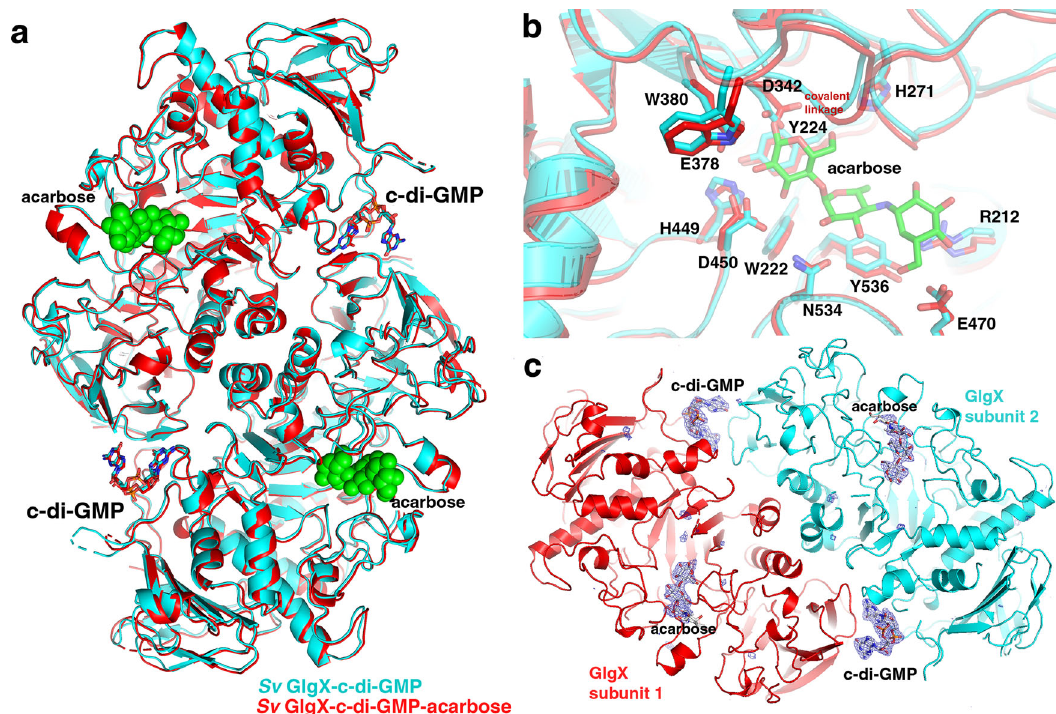
Fig. 7 | Structures of S. venezuelae GlgX-c-di-GMP-acarbose complexes. a Structure of the S. venezuelae GlgX-c-di-GMP-acarbose complex (pH 8.5) (red) superimposed ontothe S.venezuelae GlgX-c-di-GMPcomplex(cyan).Theacarbose molecules are bound in the active site and shown as green spheres. The c-di-GMP molecules are bound at the ends, in the identical location in both structures. b Close up of the bound acarbose in the S. venezuelae GlgX-c-di-GMP-acarbose complex(red). Shown are the side chains of theresiduesthat contactthe acarbose